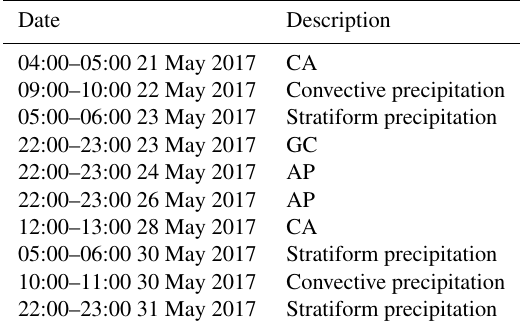
Table 4. List of events used for evaluating algorithm performance